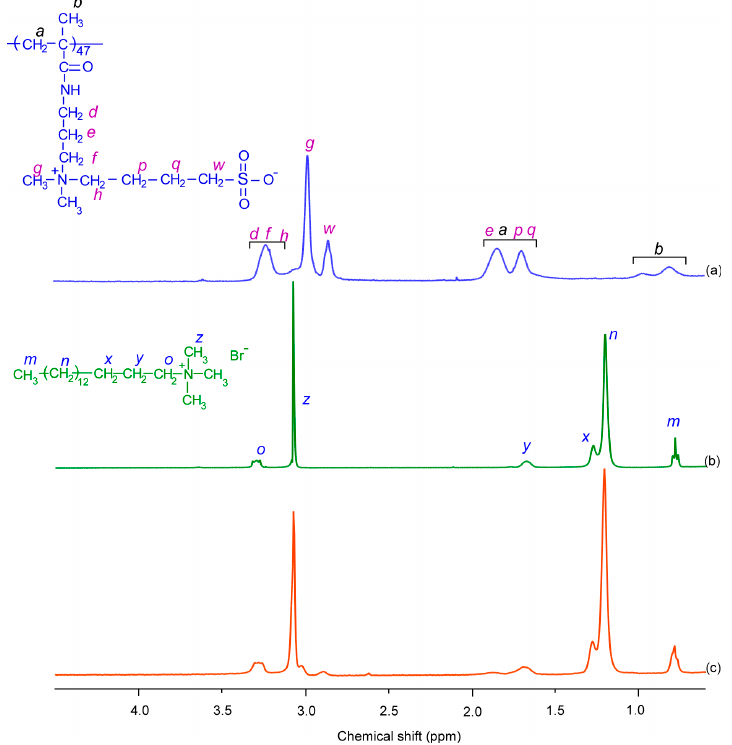
Figure 2. 1 H NMR spectra of ( a ) PSBP at 2.0 g/L (6.72 mM of SBP), ( b ) CTAB at 2.0 g/L (5.48 mM), and ( c ) the PSBP/CTAB complex with a mixing ratio of 0.5 at 25 °C within a complex concentration of 0.69 g/L in D 2 O containing 0.1 M NaCl.